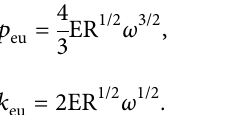
Figure 2: Schematic diagram of a deformed asperity before and after loading and